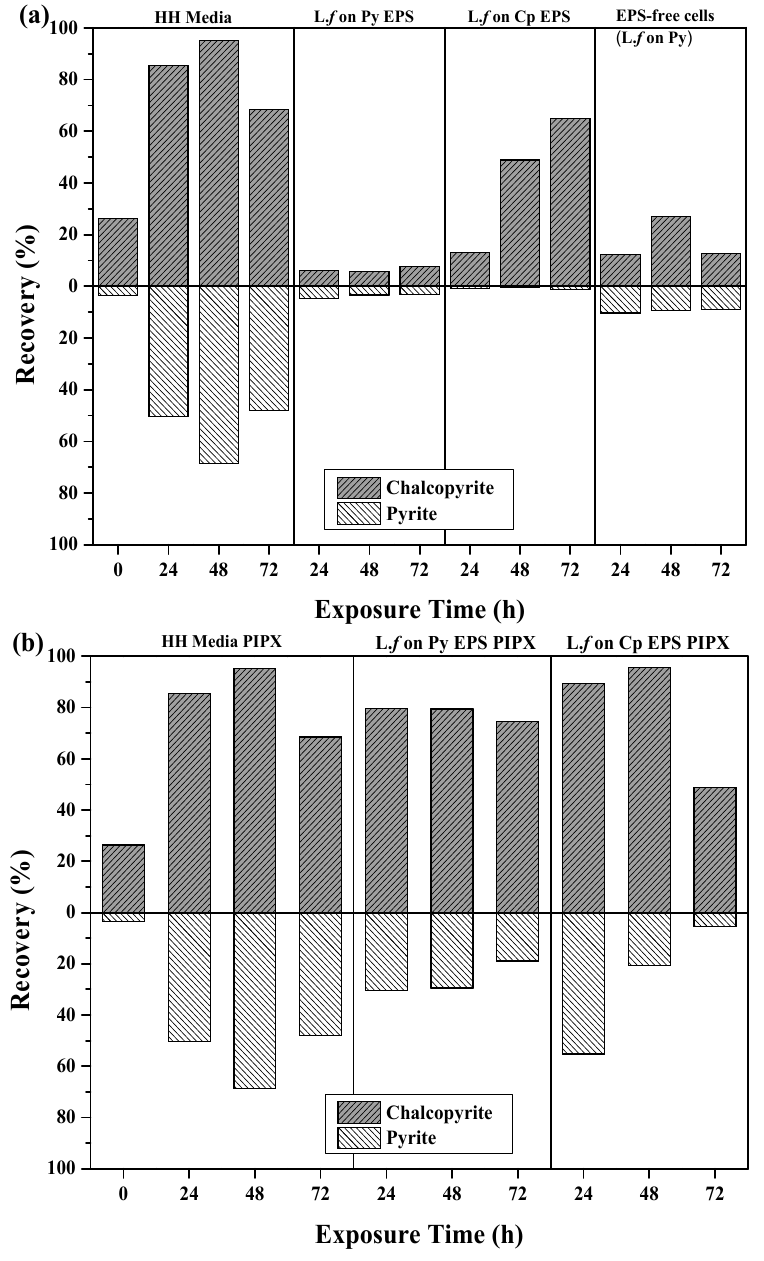
Figure 7. Recovery of Cp and Py using extracted EPS supernatant; ( a ) collectorless flotation tests and ( b ) in the presence of PIPX collector.